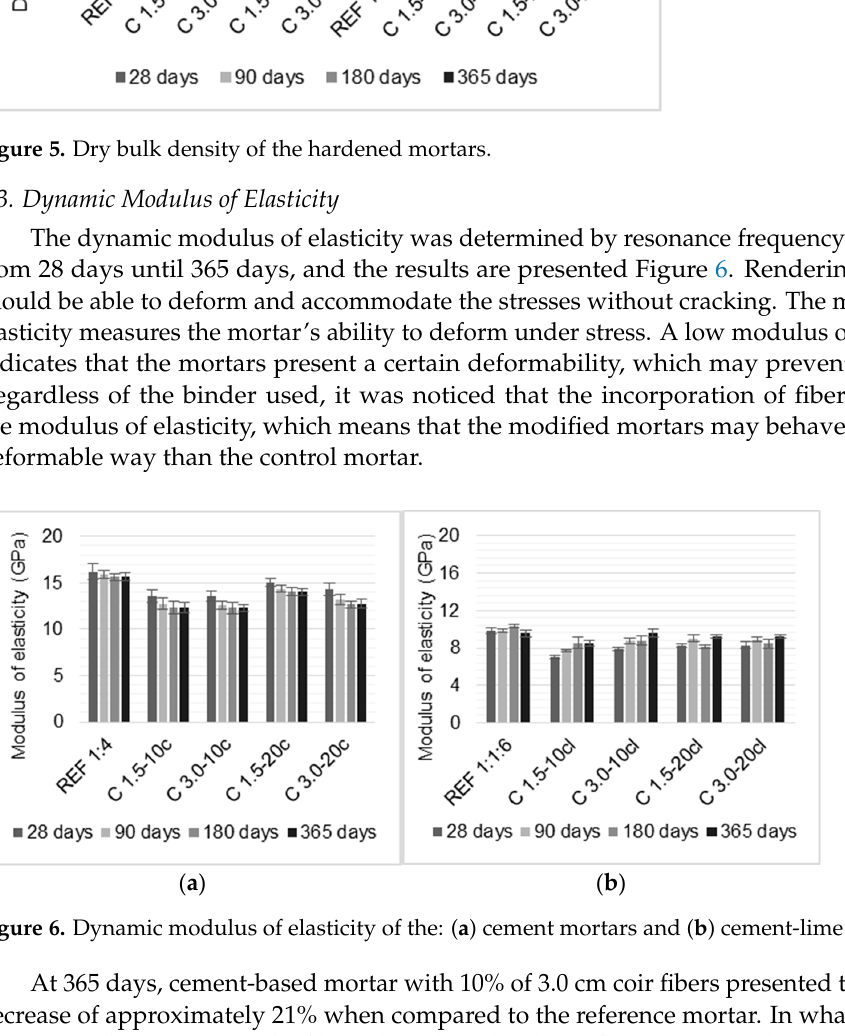
Figure 5. Dry bulk density of the hardened mortars.